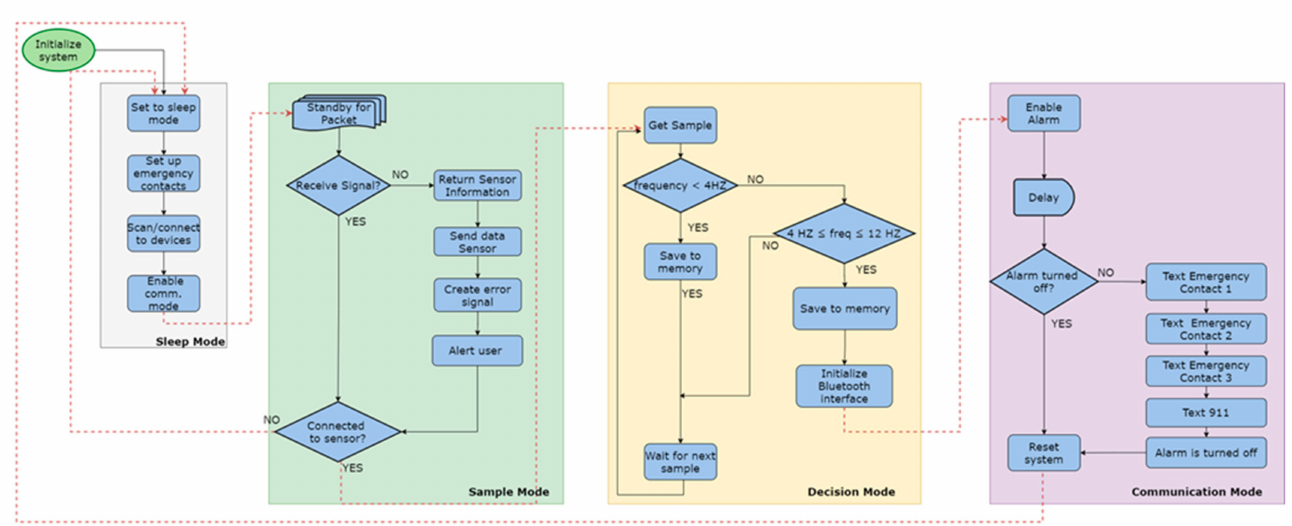
Figure 4. DiAtack Mobile